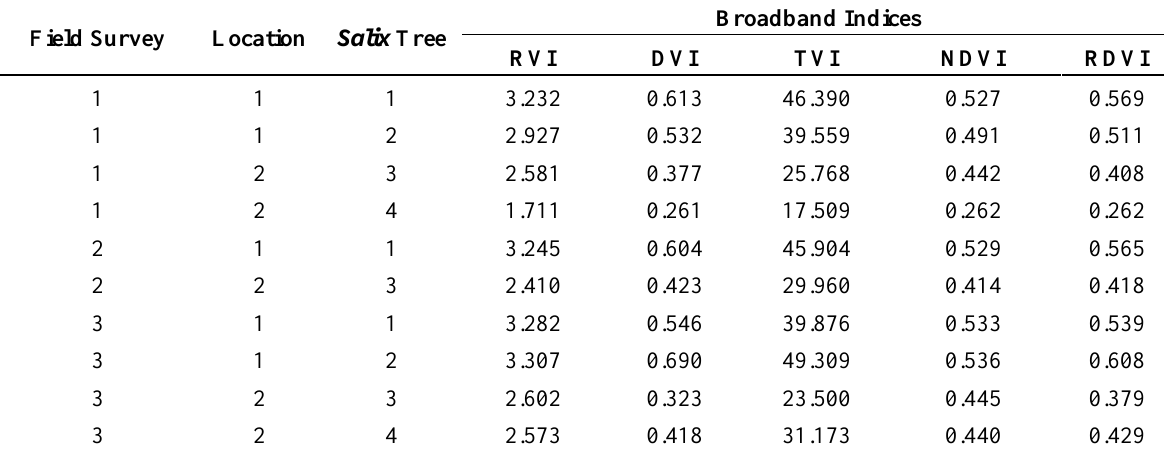
Table 3. Broadband vegetation